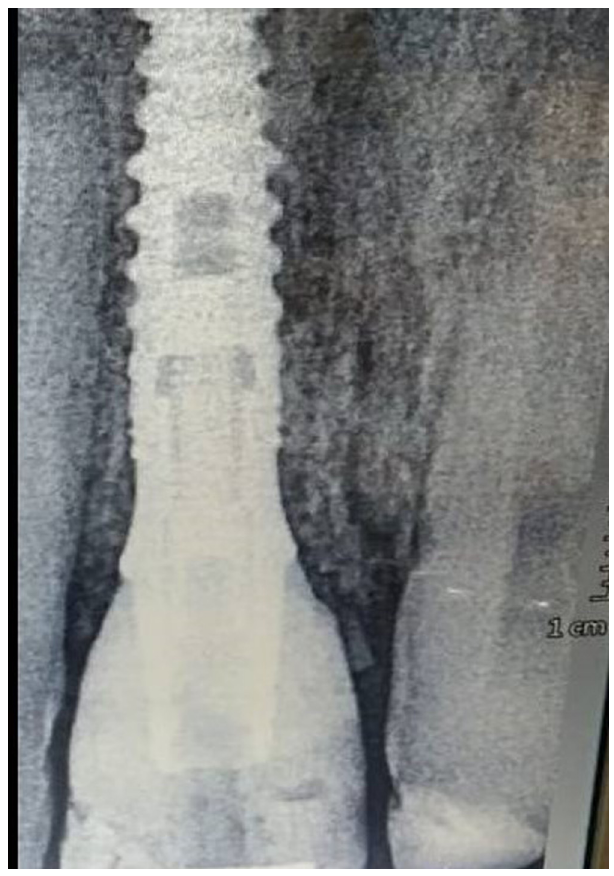
Fig. 6. Post operative IOPA radiograph at four year follow up.